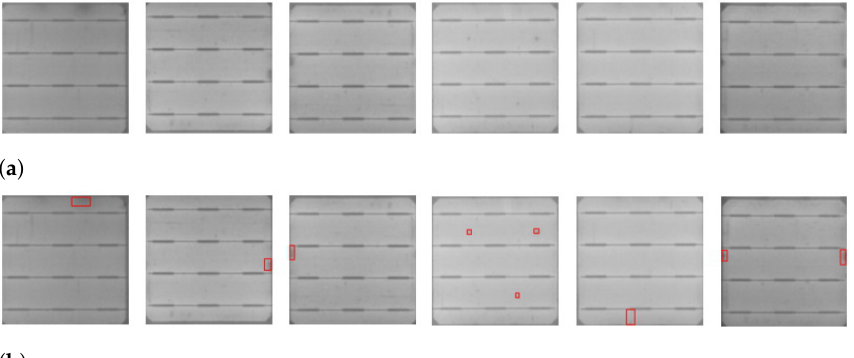
Figure 17. Misdetected cells with defects. ( a ) The original cell images. ( b ) Their ground truth annotations of defects.